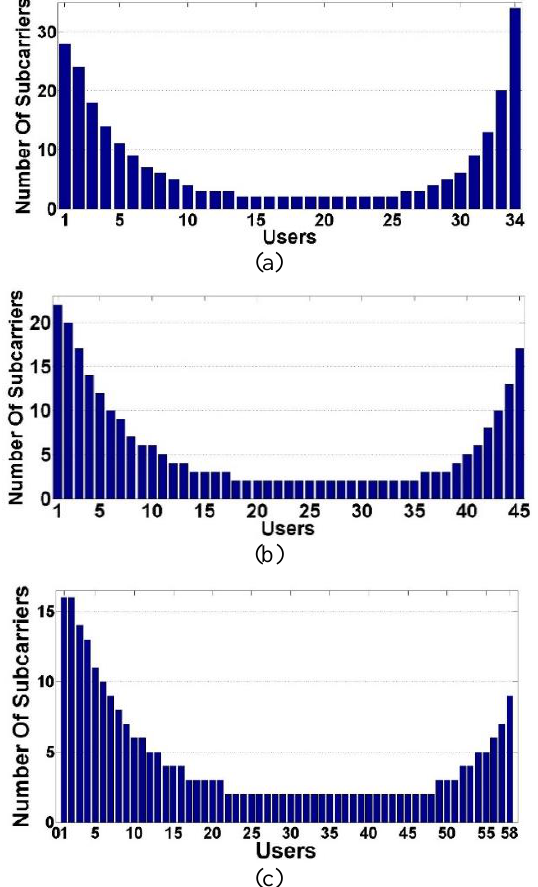
Fig. 9. Subcarriers allocation considering cell’s capacity in terms of number of satisfied users for various ranges of the adopted values of discount factor δ by the users: (a) δ i+1 = δ i +0.006 , δ 1 =0.782 , (b) δ i+1 = δ i +0.003 , δ 1 =0.848 and (c) δ i+1 = δ i +0.0015 , δ 1 =0.8945.